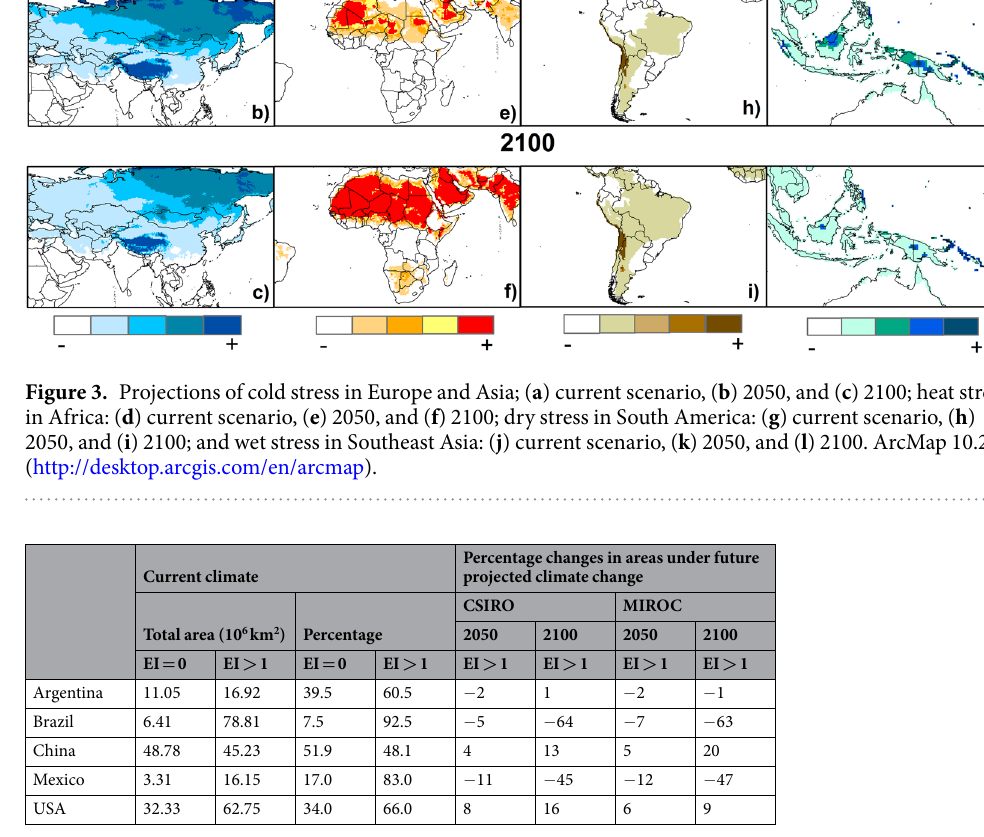
Table 3. Projected unsuitable and suitable areas for the five major producers of maize under current climate conditions and coverage. Percentage changes indicate alterations under the future projected climate in relation to the current climate. EI = 0, unsuitable area. EI > 1 includes three categories: marginal, suitable and optimal suitability. Note that these are the total suitable projected areas and not the actual areas under maize